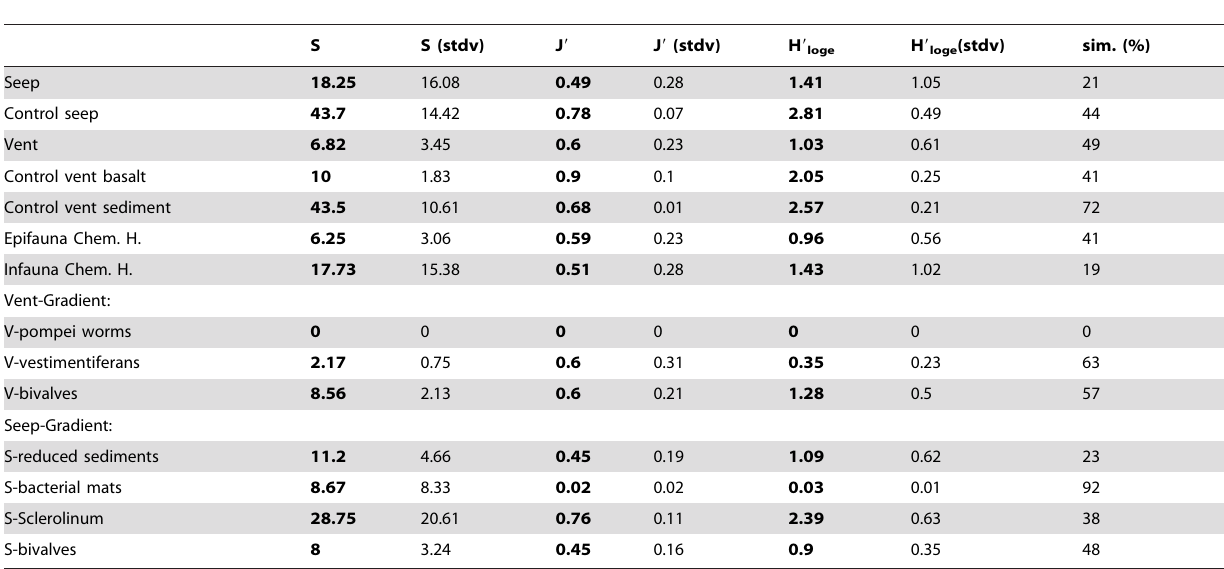
Table 5. Mean nematode genera richness (S), standard deviation of genera richness (S stdv), Pielou’s evenness (J 9 ) and its standard deviation, and Shannon diversity index (H 9 loge ) and its standard deviation are presented for all yet available data from deep-sea cold seeps (seep) and hydrothermal vents (vent).